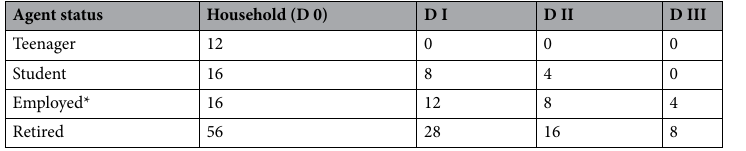
gender, SES, and the cumulative unmet care need experienced by that agent. We therefore assume that large amounts of unmet care need increase frailty.